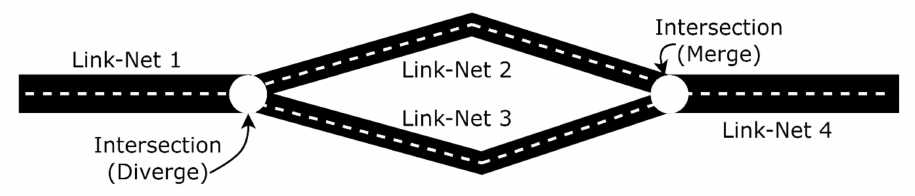
Figure 2. Illustration of network, Links, and